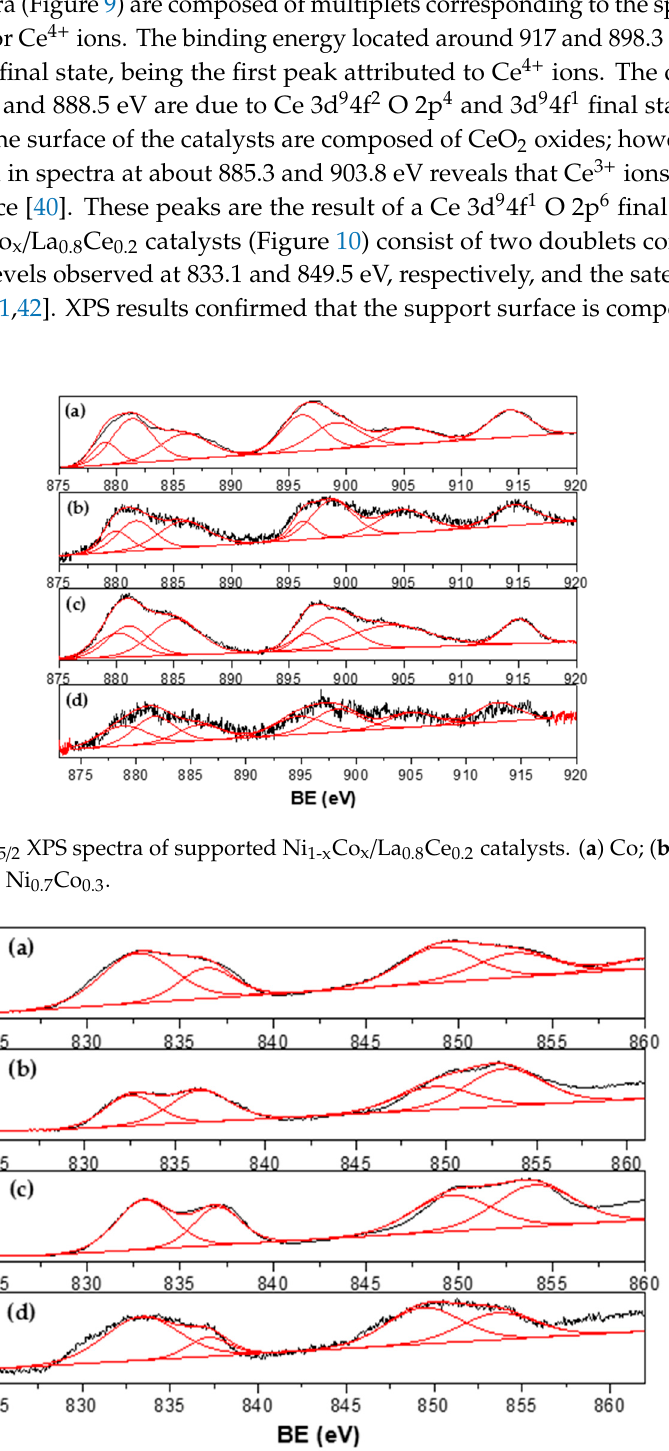
Figure 8. Co 2p XPS spectra of ( a ) Co/La 0.8 Ce 0.2 ; ( b ) Ni 0.1 Co 0.9 /La 0.8 Ce 0.2 ; ( c ) Ni 0.4 Co 0.6 /La 0.8 Ce 0.2 ; and ( d ) Ni 0.7 Co 0.3 /La 0.8 Ce 0.2.